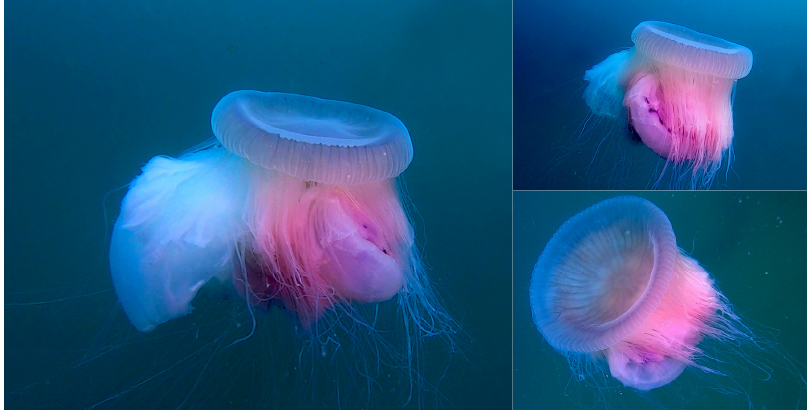
Figure 1. Drymonema dalmatinum preying on two Rhizostoma pulmo medusae.